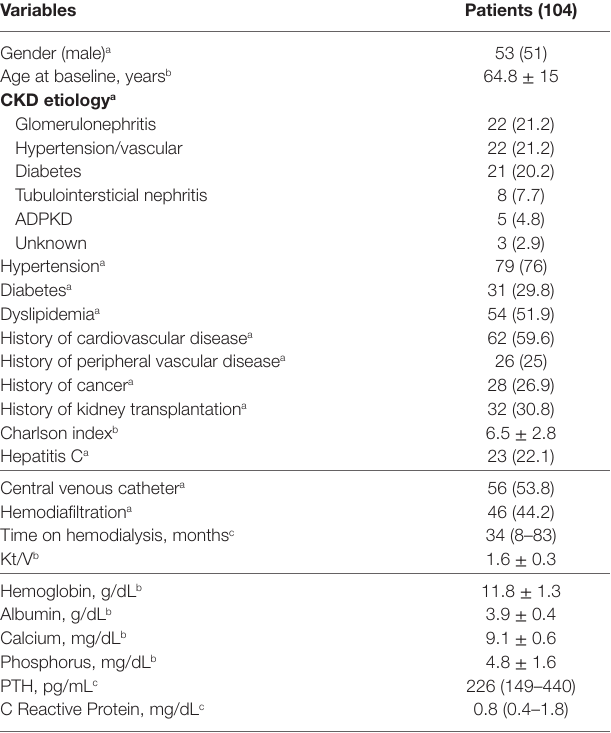
TaBle 1 | Baseline characteristics of the study group.